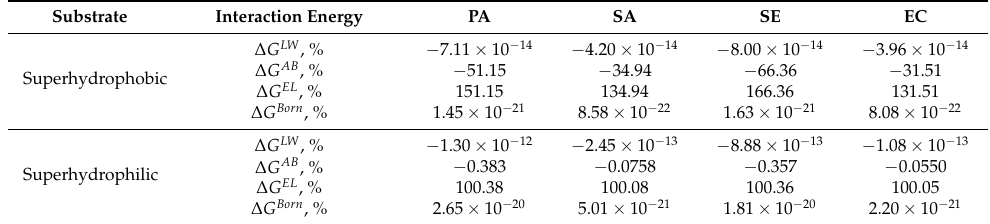
Table 4. Percent contribution to ∆ G tot of extended DLVO components ( ∆ G LW , ∆ G AB , ∆ G EL , and ∆ G Born ) for bacterial (PA, SA, SE, and EC) interactions with superhydrophobic and superhydrophilic substrates at d eq where negative percentages illustrate adhesive (i.e., spontaneous) interactions and positive percentages illustrate repulsive (i.e., non-spontaneous) interactions. Substrate Interaction Energy